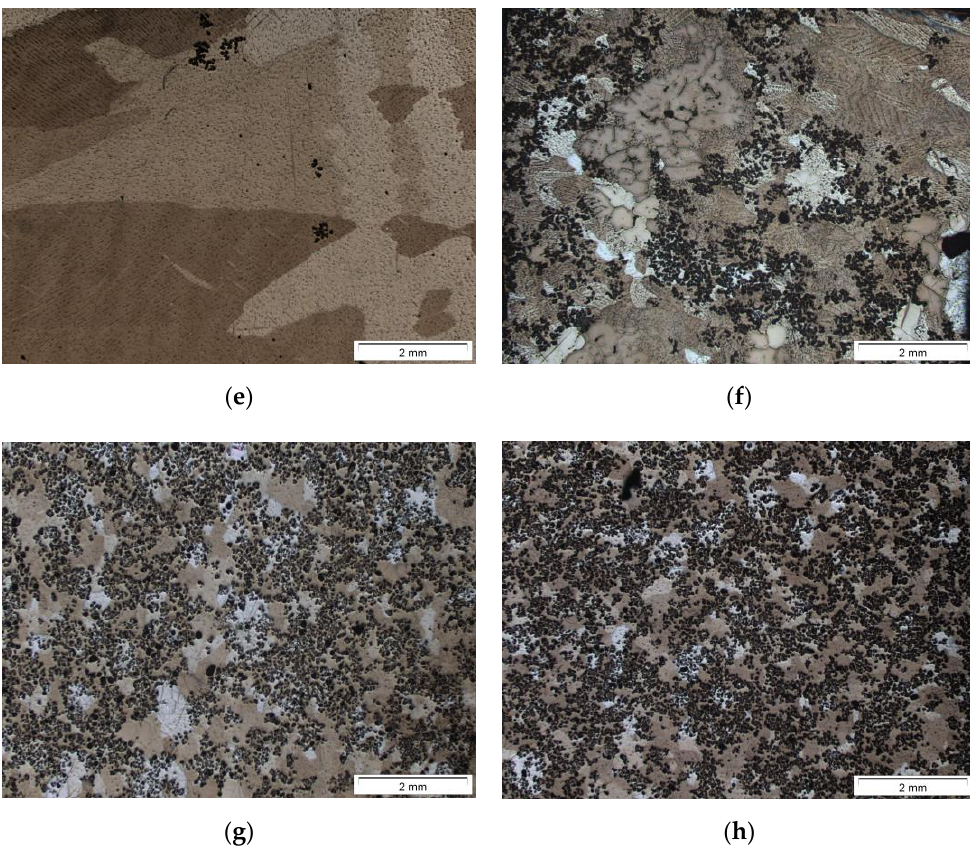
Figure 1. As-cast microstructures of pure Mg with ( a ) 0, ( b ) 0.75, ( c ) 1.0, and ( d ) 0.5AlN and ZW0303 with ( e ) 0, ( f ) 0.75, ( g ) 1.0, and ( h ) 1.5AlN.